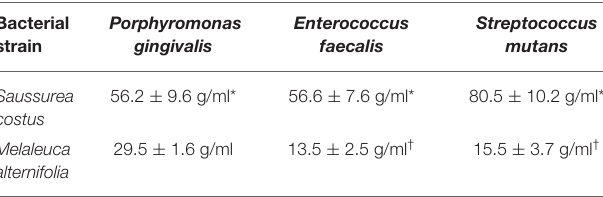
TABLE 1 | Minimum inhibitory concentrations of Saussurea costus and Melaleuca alternifolia in relation to their bactericidal efficacy. Bacterial